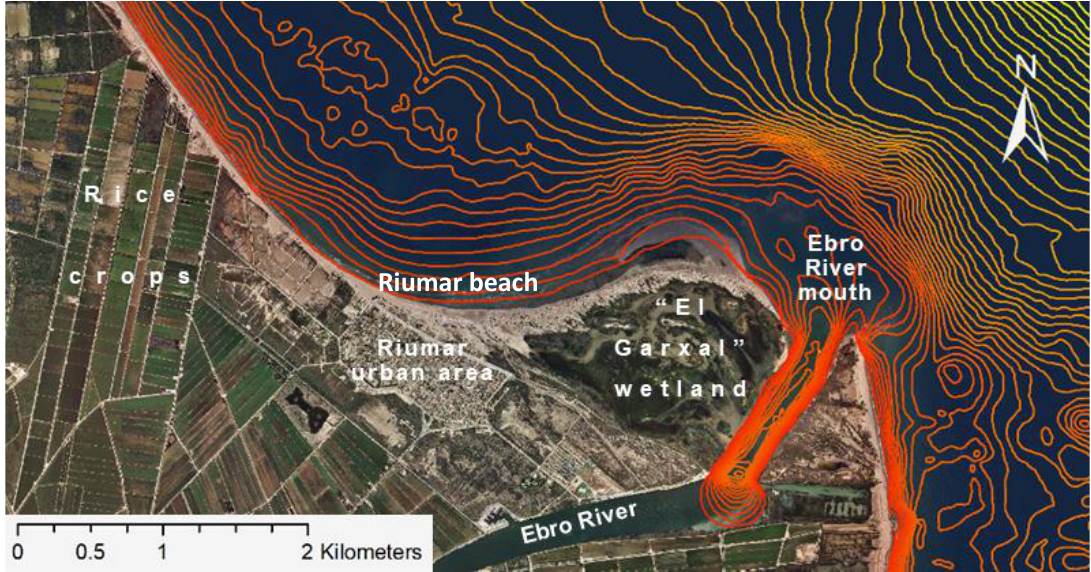
Figure 2. Study site orthophoto and bathymetry. Modified from ICGC (http://www.icc.cat/vissir3/). The separation between isobaths is 50 cm. The white straight lines are roads. The coastal dune barrier extends along the entire coast, from the river mouth to the left end of the figure (see also Figure 5).